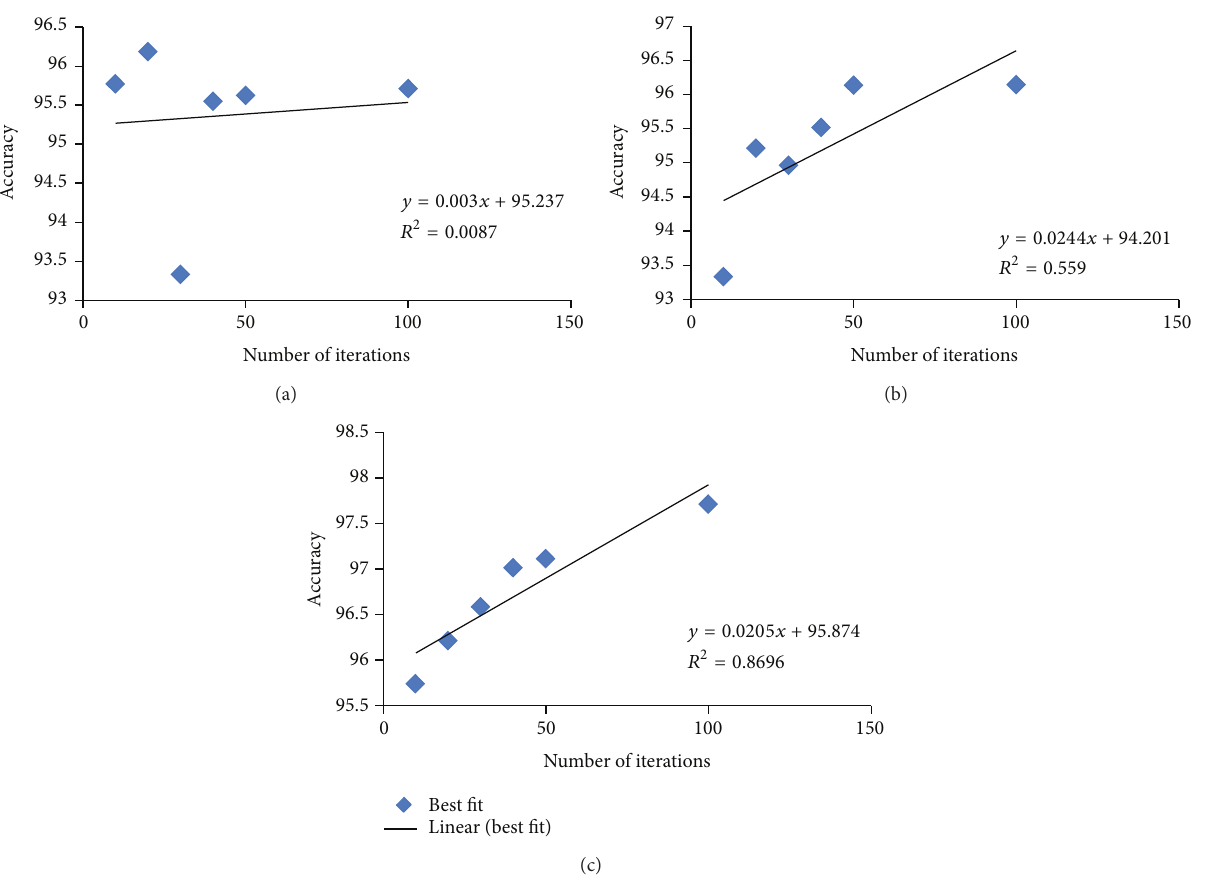
Figure 10: Performance measure of data 2 for the three algorithms: (a) fuzzy 𝐶 -means clustering, (b) fuzzy 𝐾 -means clustering, and (c) fuzzy subtractive